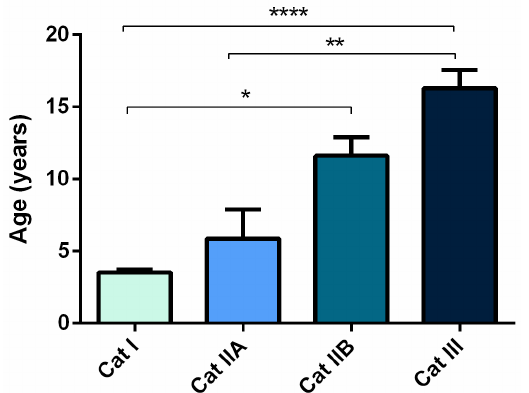
Figure 1. Age of the mares (mean ± SEM) with endometria assigned to different Kenney and Doig’s histopathological categories as I, IIA, IIB or III. Asterisks indicate statistical differences (* p < 0.05, ** p < 0.01, **** p < 0.0001).